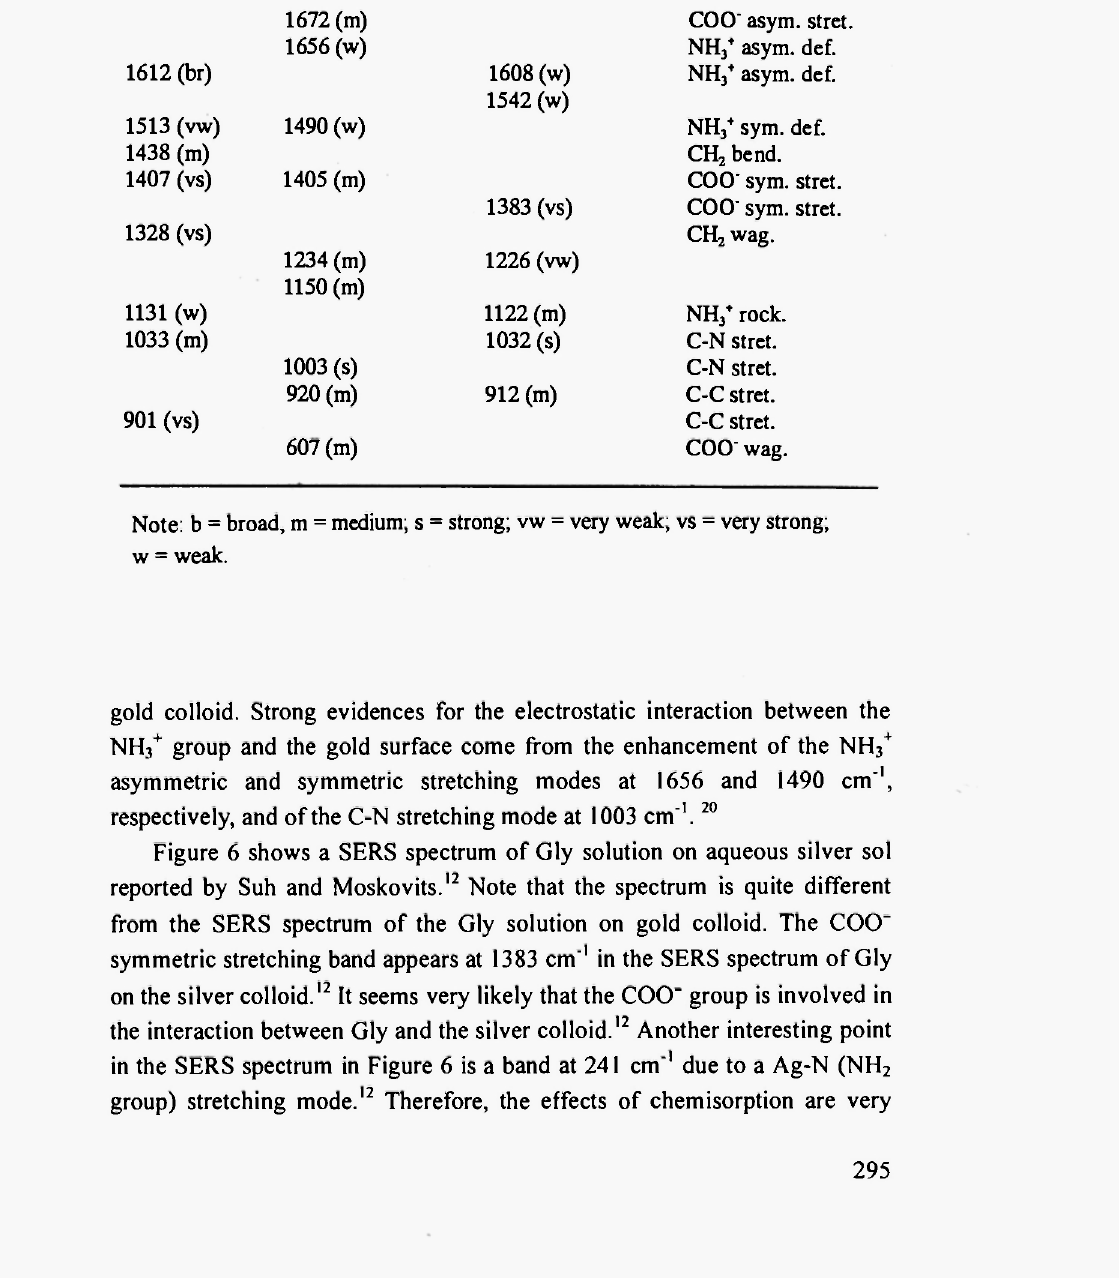
Frequencies (cm" 1 ) and assignments of bands in the normal Raman and SERS of